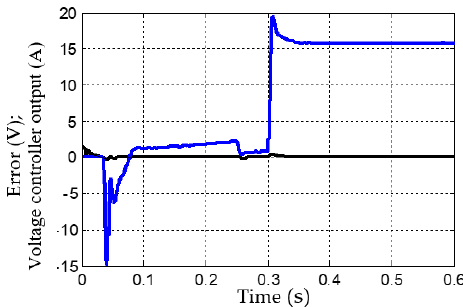
Figure 5. Evolution of the error (in black) and the output (in blue) of the voltage controller.